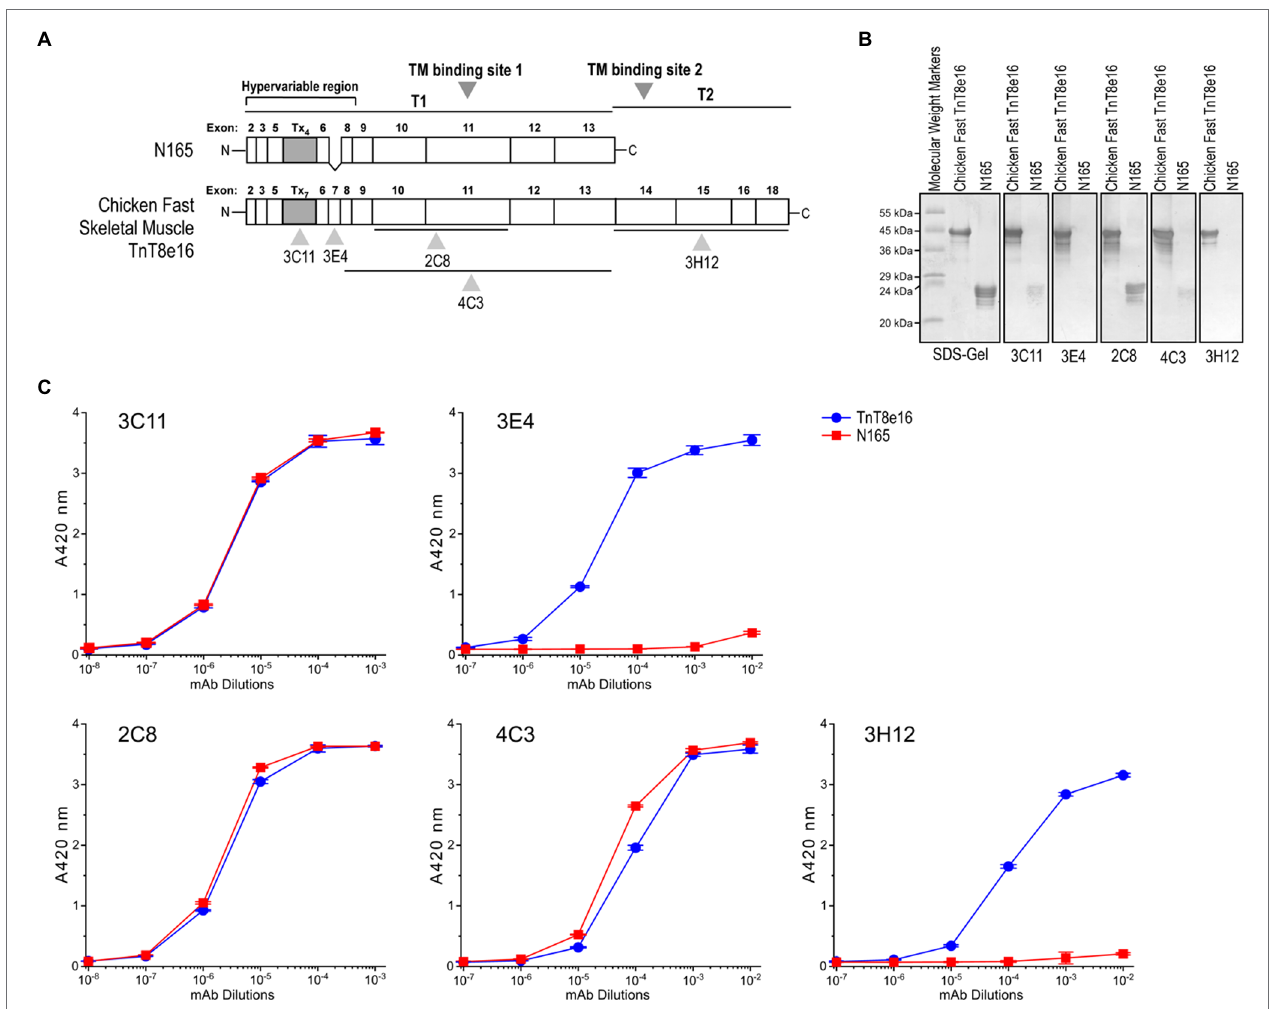
FIGURE 7 | Linear structure of chicken fast skeletal muscle TnT8e16 and epitope mapping of anti-TnT mAbs. (A) Locations of the epitopes recognized by anti-TnT mAbs used in the present study are indicated on a linear map of chicken fast TnT8e16. The Tx segment of chicken fast TnT, consisting of seven repeated H(E/A) EAH transition metal binding motifs, is encoded by alternatively-spliced exons. (B) Western blotting and (C) ELISA using intact chicken TnT8e16 and N-terminal T1 fragment N165 demonstrated that mAbs 2C8, 4C3, and 3C11 epitopes are contained within the N165 peptide, while the 3H12 epitope is outside of N165. mAb 3E4 had no reaction with N165 due to the lack of exon 7-encoded segment, serving as a background